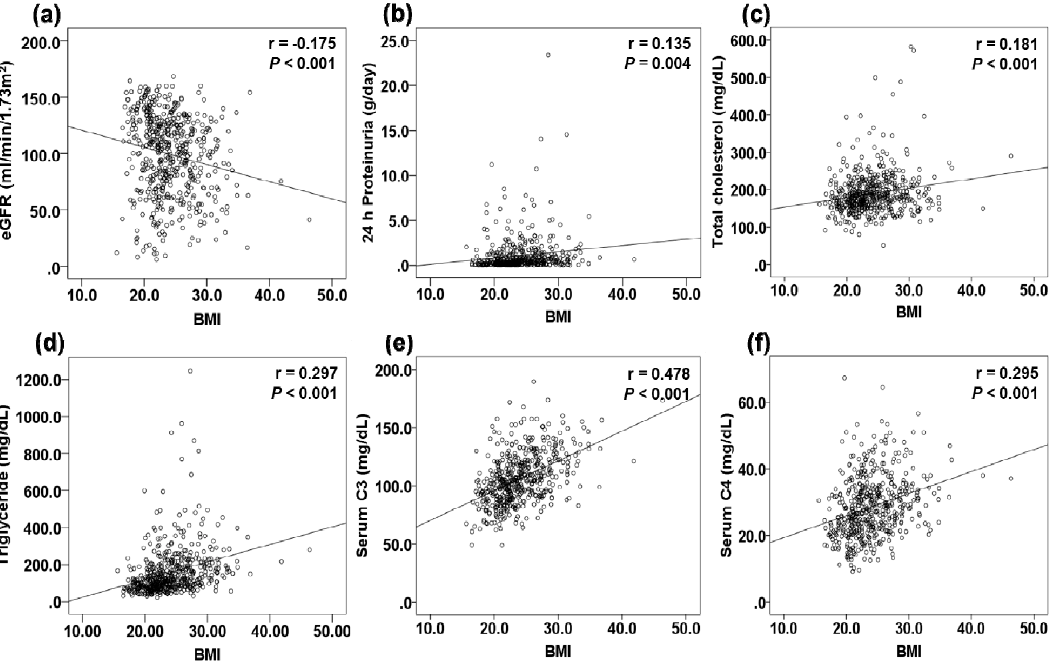
Figure 2. The correlation graphs between BMI and clinical variables. ( a ) CKD-EPI eGFR. ( b ) 24 h proteinuria. ( c ) Total cholesterol level. ( d ) Triglyceride level. ( e ) Serum C3 level. ( f ) Serum C4 level. Table 6. Linear regression analysis for renal function and 24-h proteinuria.